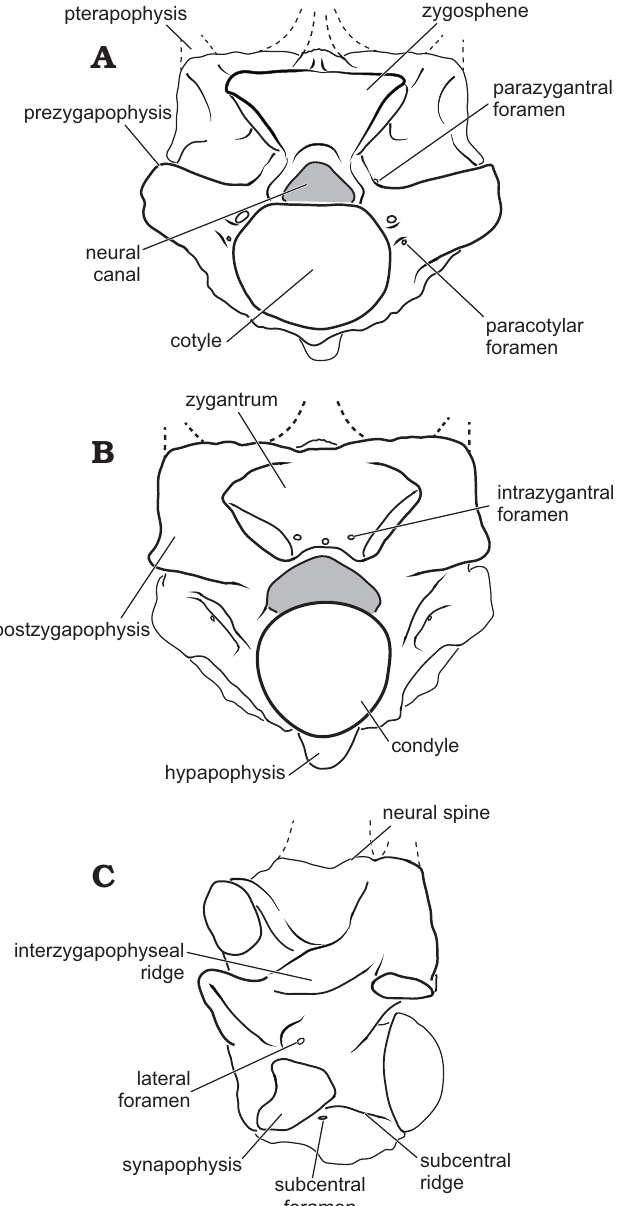
Fig. 1. Basic snake vertebral anatomy based on Palaeophis colossaeus (CNRST-SUNY 294) from the Eocene of Mali; in anterior ( A ), posterior ( B ), and lateral ( C )